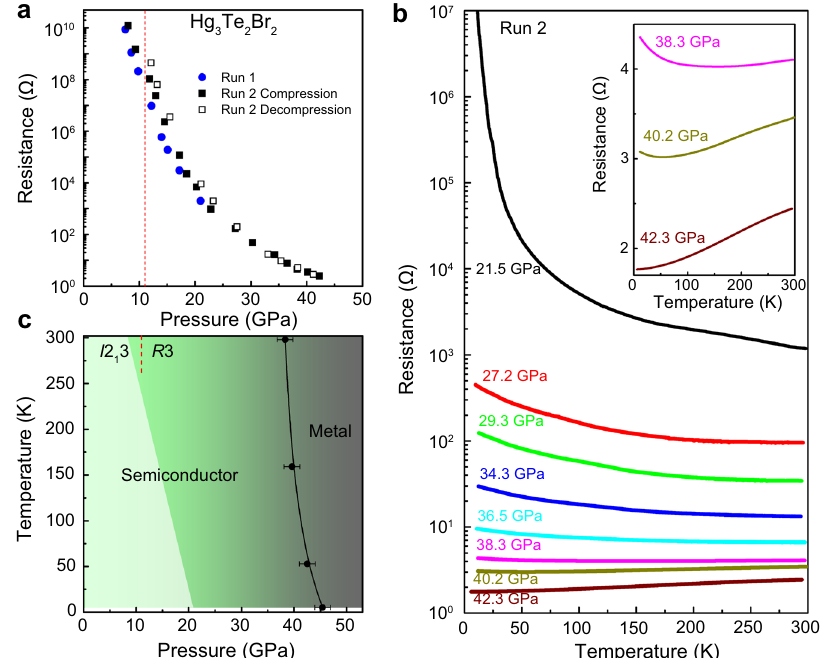
Fig. 3 Pressure-induced metallization of Hg 3 Te 2 Br 2 . a Pressure-dependent electrical resistances of Hg 3 Te 2 Br 2 at room temperature. b Temperature dependence of the electrical resistance of Hg 3 Te 2 Br 2 at different pressures. The inset enhances the semiconductor-to-metal transition at 42.3 GPa. c P – T phase diagram of Hg 3 Te 2 Br 2 on the basis of resistance measurements. Solid line: semiconductor – metal phase temperature dependence of the electrical resistance of Hg 3 Te 2 Br 2 >21.0 GPa (Fig. 3b) and observed a gradual transition from